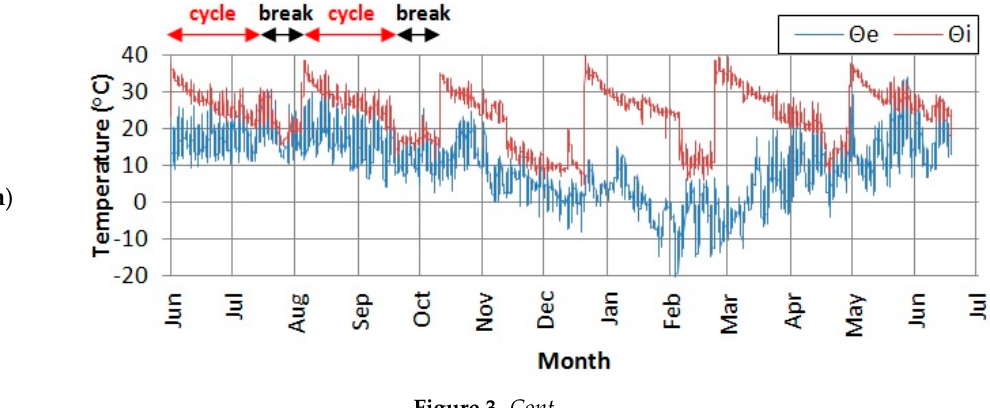
Table 1. Physical parameters of the soil and construction materials used in the calculations.